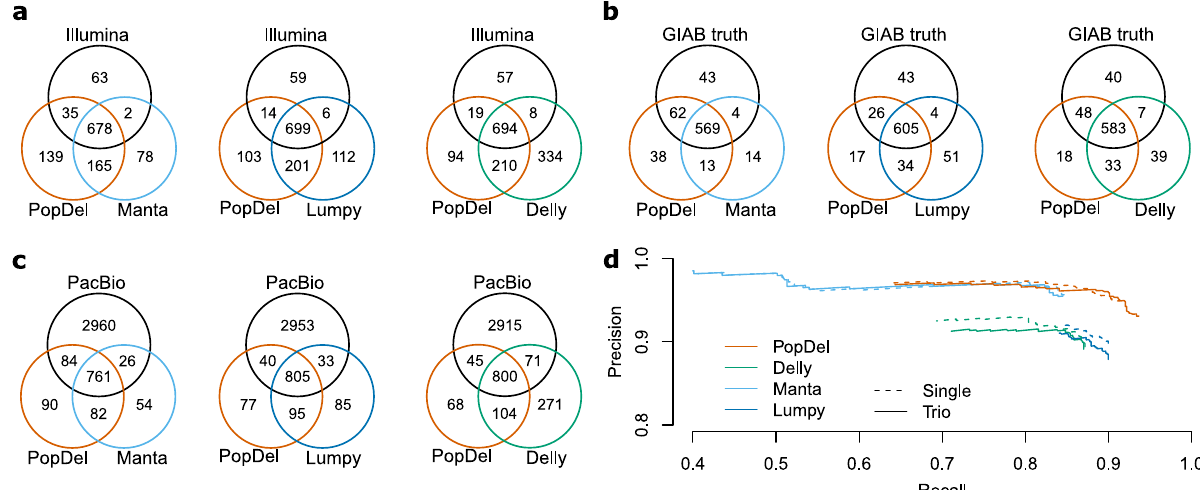
Fig. 3 Accuracy of our approach on Genome-in-a-Bottle (GIAB) benchmark genomes. We compared PopDel on HG001 and HG002 to Manta, Lumpy (via Smoove), and Delly using a minimum reciprocal overlap criterium of 50%. Call set overlap for HG001 with a the Genome-in-a-Bottle short-read reference set of deletions and c a deletion set called from PacBio long read data. b Call set overlap for HG002 with deletions from the Genome-in-a-Bottle preliminary variant set. d Precision-recall curve when calling deletions from HG002 alone (Single) or jointly with the parental genomes (Trio) for different genotype quality